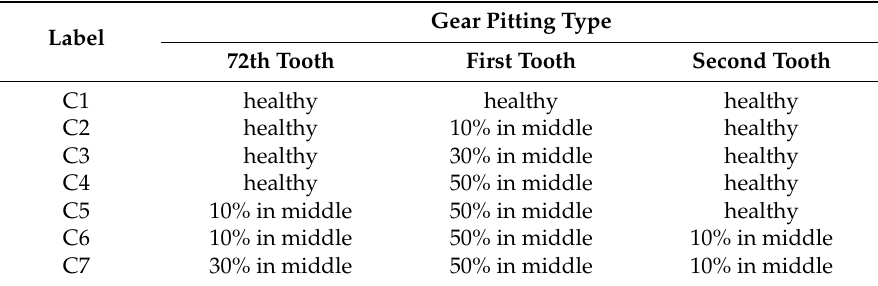
Table 2. Driven gear pitting